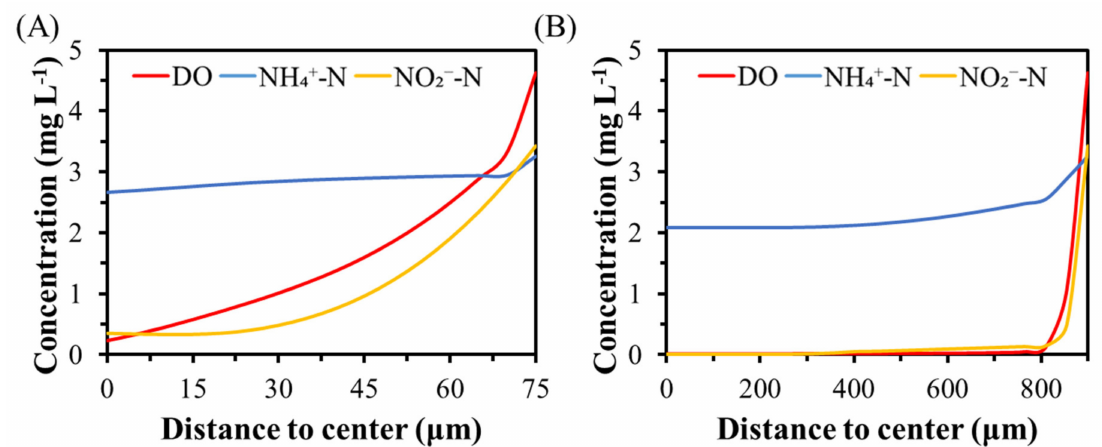
Figure 7. Model simulation of substrate utilization profiles in bioflocs (150 µ m diameter, ( A )) and granules (1800 µ m diameter, ( B